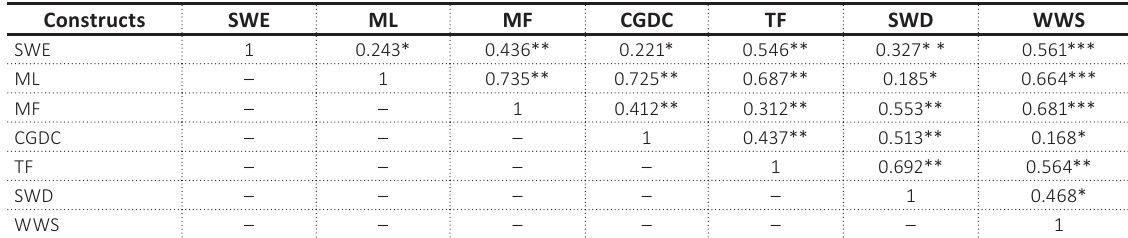
Source: Author’s